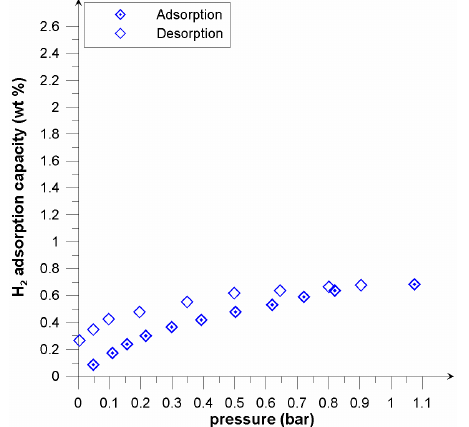
Figure 3. Apparatus used for measurements of hydrogen adsorption-desorption (V1-V4-valves, P-pressure transducer).